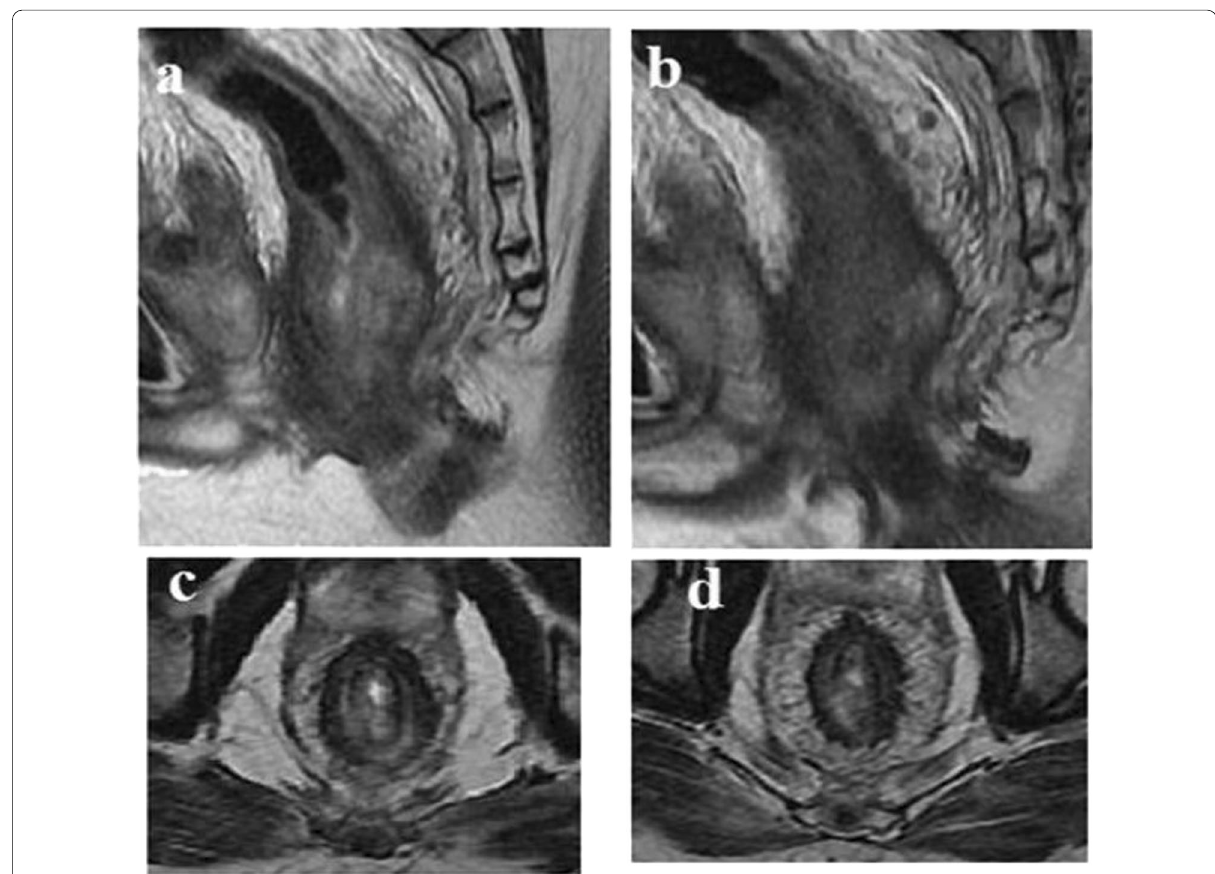
Fig. 3 a–d Follow-up MRI study for same patient in Fig. 1. a, b sagittal T2 WIs, c, d axial T2 WIs, revealed better delineation of focal area of intermediate T2 signal seen involving the lower rectum (correlated to the same area found on the PET CT scan, 6–7 O’clock) and showing size progression as well, confirming the viable tumoral growth that was missed on the previous MRI due to the predominant fibrotic